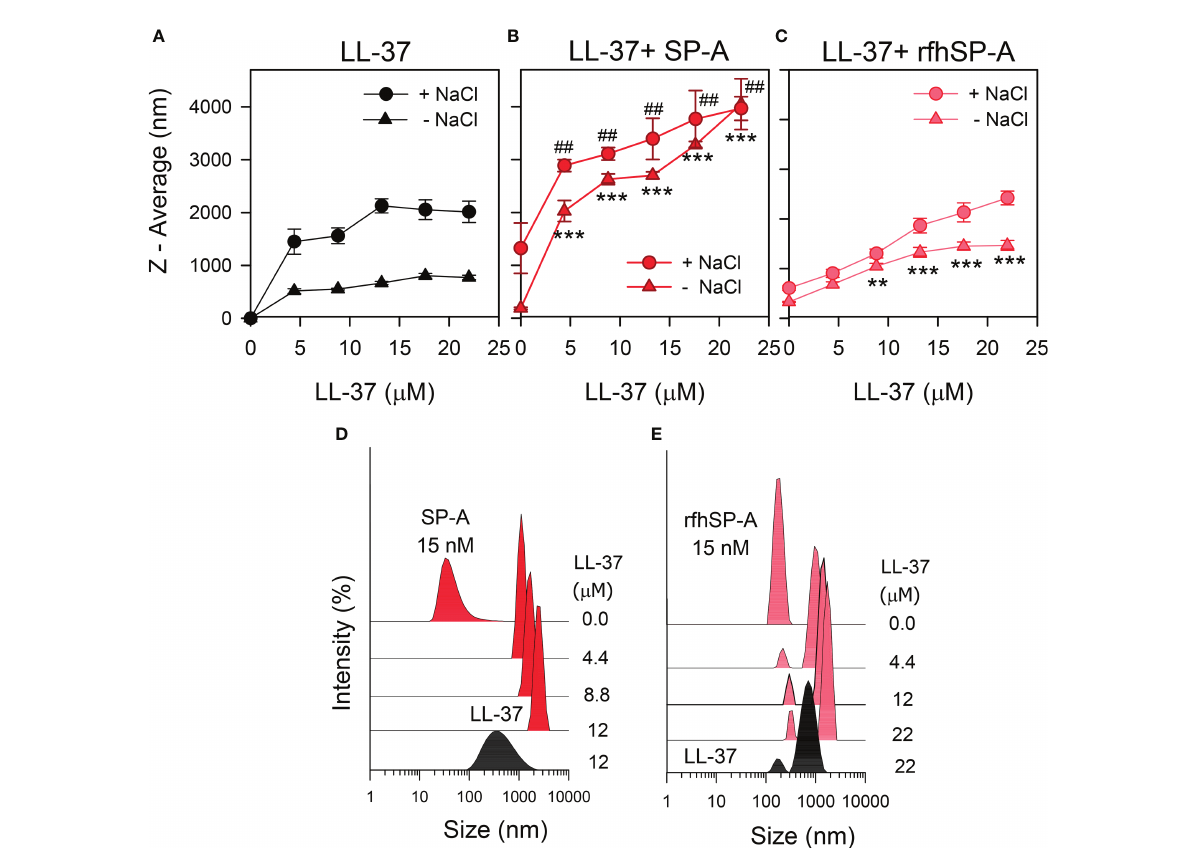
FIGURE 3 SP-A and rfhSP-A form molecular aggregates with LL-37. The formation of complexes between LL-37 and either SP-A or rfhSP-A in solution was examined in the presence and absence of salts by dynamic light scattering. (A) NaCl effect on the overall Z-average of LL-37 particles. (B) Dependence of Z-average of LL-37/SP-A mixtures on the concentration of LL-37 in the presence and absence of NaCl. (C) Dependence of Z-average of LL-37/rfhSP-A mixtures on the LL-37 concentration, with and without NaCl. SP-A and rfhSP-A concentrations in (B, C) were 10 µg/ml for SP-A and 0.87 µg/ml for rfhSP-A, corresponding to 15 nM. Results are the mean ± SD of four experiments. For statistical analysis, Student ’ s T-test was used: ** p < 0.01; *** p < 0.001 when the effect of the presence of SP-A or rfhSP-A in the mixture was compared with LL-37 alone in the absence of NaCl. ## p < 0.001when the effect of the presence of SP-A or rfhSP-A in the mixture was compared with LL-37 alone in the presence of NaCl. In (D) it is shown a representative experiment of the formation of SP-A/LL-37 aggregates upon addition of increasing concentration of LL-37 to a solution containing a constant concentration of SP-A (15 nM) in 5 mM Tris-HCl buffer (pH 7.4). DLS analyses of LL- 37 particles alone is also shown in the graph. In (E) a representative experiment of the formation of rfhSP-A/LL-37 aggregates is also shown under the same conditions as in (D) In (D, E) , the y-axis is the relative intensity of the scattered light, and the x-axis represents the hydrodynamic diameter of the particles present in the